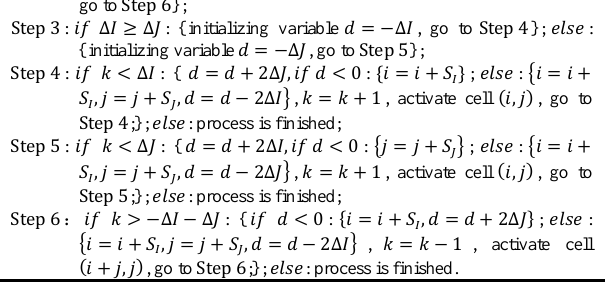
Table 2. Linear vector filling algorithm on the planar hexagon